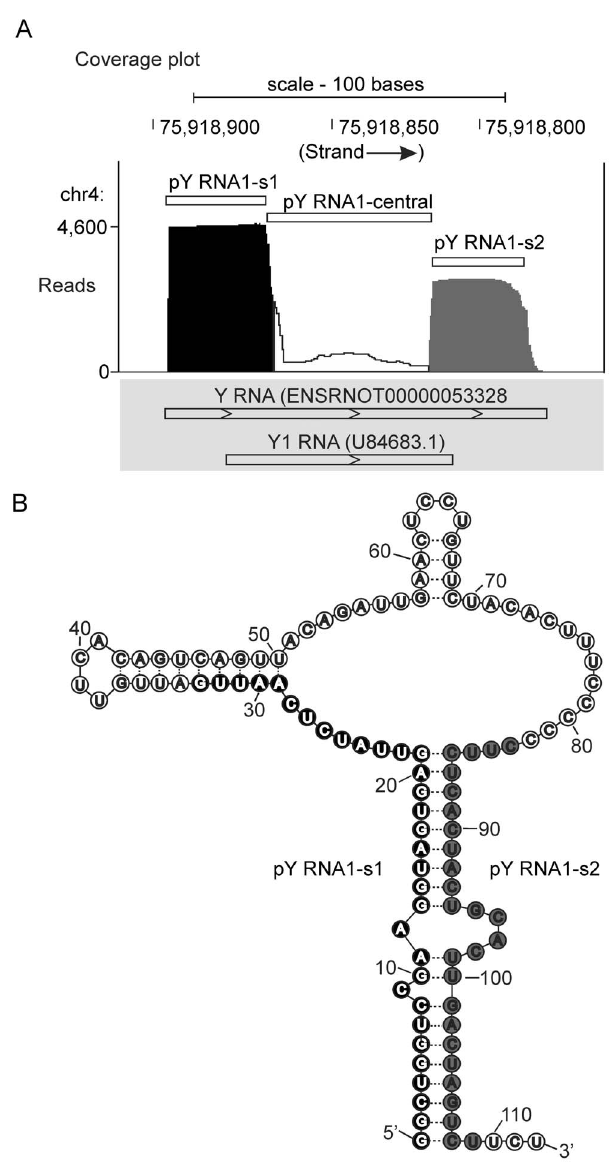
Figure 1. Massively parallel sequencing of small RNAs purified from the rodent pineal gland [ 17 ] . A. Coverage plot indicating the number of reads aligned to the rat genome (build rn4) using the Novoalign alignment tool and visualized using the UCSC genome browser [49]. The aligner was used with ‘miRNA mode’ switched on and multiple good–quality alignments (of each read) were reported, full details in ‘‘Materials and Methods’’. Reads that align to the small cytoplasmic Y RNA1 and are distributed into two distinct populations, indicated by black (5 9 stem region; pY RNA1-s1) and grey (3 9 stem region; pY RNA1-s2) shading. Approximately 4,600 reads map to Y RNA- s1 and , 3,000 to pY RNA1-s2. The transcripts indicated in the grey box are the Ensembl prediction for Y RNA1 and the incomplete Genbank entry for Y RNA1 in rat (U84683.1). Approximately 20 bases are missing from the 5 9 and 3 9 end GenBank entry U84683.1, as indicated by the histogram above. B. Secondary structure of the Y RNA gene adapted from [22], modified to reflect the locations of pY RNA1-S1 and pY RNA1- s2: the location of processed small RNAs is indicated with black and grey circles (pY RNA1-s1 and pY RNA1-s2, respectively) that correspond to the coverage plot in A .